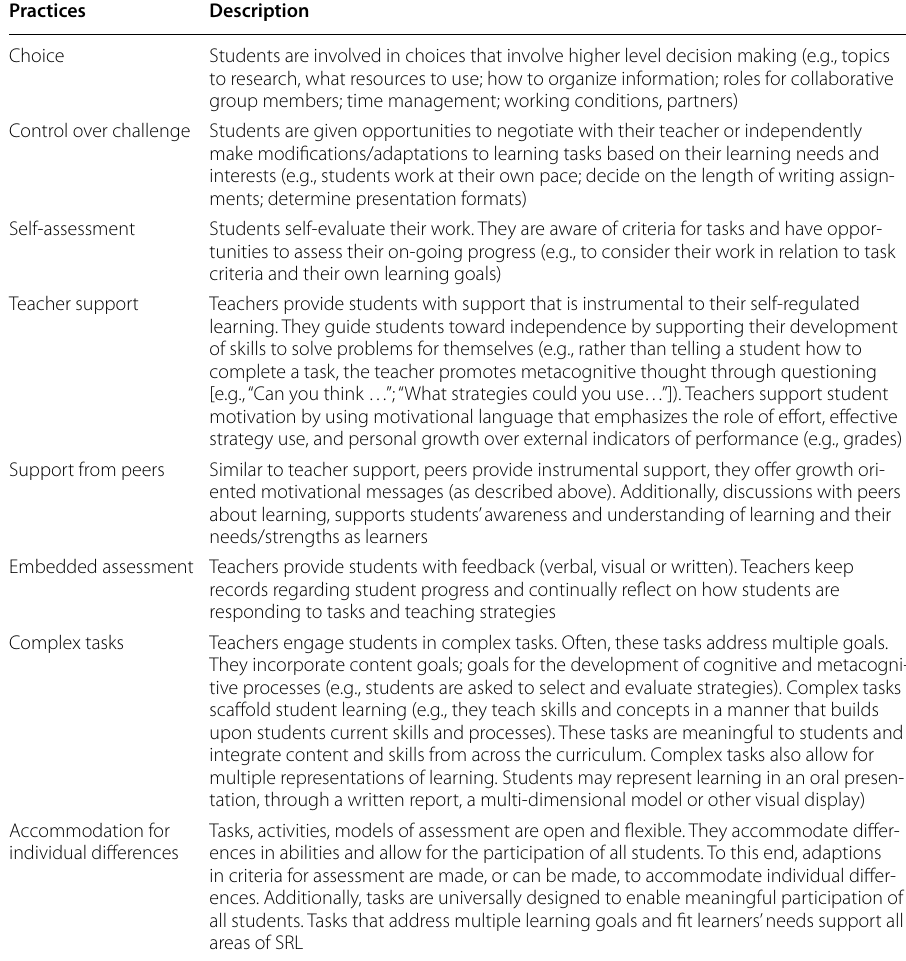
Adapted from Perry, 1998, 2013